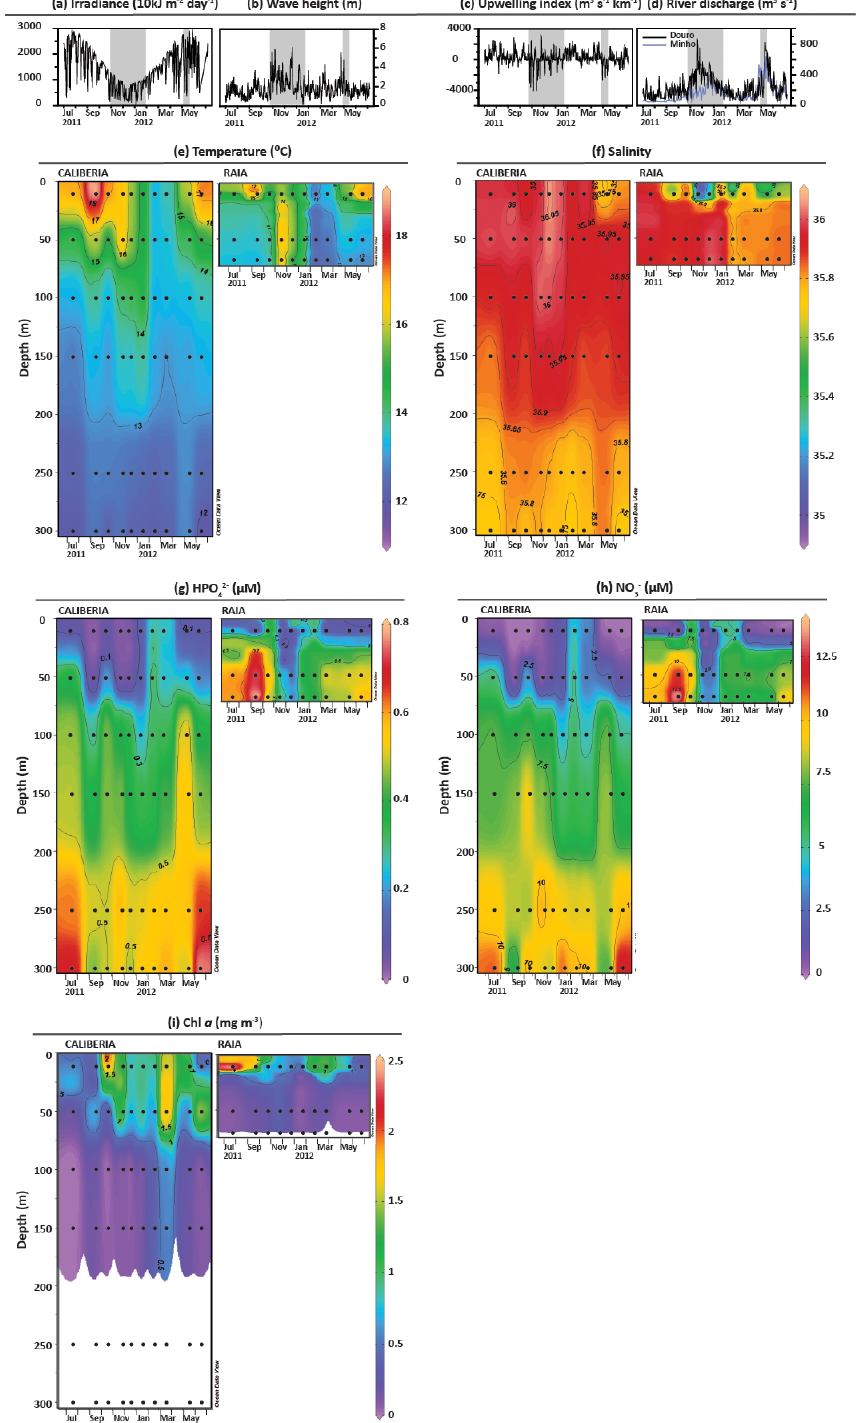
Figure 2. Environmental conditions for the studied period. Available data on (a) irradiance, (b) wave height, (c) Bakun’s upwelling index, and (d) discharges by Minho (blue) and Douro (black) rivers (Zúñiga et al., 2016, 2017). Grey and white bars represent downwelling and upwelling periods, respectively, based on upwelling index and biogeochemical data presented and interpreted in Zúñiga et al. (2016, 2017). Temporal and vertical distribution of (e) temperature, (f) salinity, (g) HPO 2 − Black dots represent collected water samples for coccolithophore